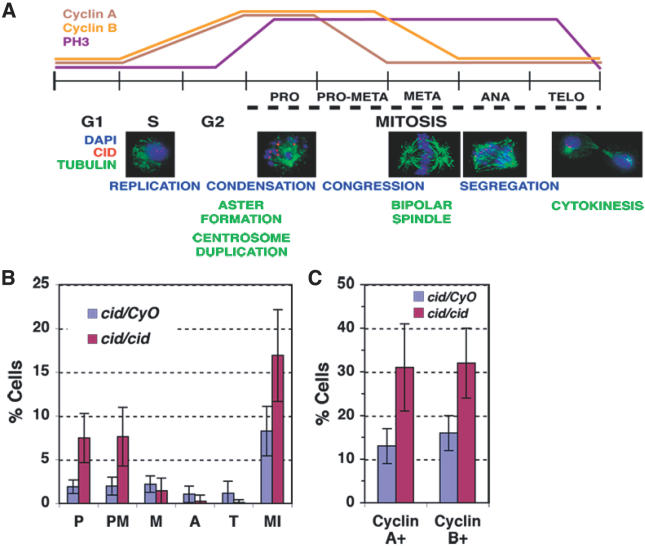

cid Null Mutants Exhibit a G2/Prophase Delay.Cell cycle progression was monitored in cid/CyO and cid/cid embryos by staining for PH3, cyclin A, cyclin B, and tubulin.(A) Schematic diagram of the appearance and destruction of various cell cycle regulatory factors and markers. ANA, anaphase; META, metaphase; PRO, prophase; PRO-META, prometaphase; TELO, telophase.(B) cid/cid animals displayed an elevated mitotic index, and an increased number of cells in prophase and prometaphase, compared to cid/CyO controls. A, anaphase; M, metaphase; MI, mitotic index; P, prophase; PM, prometaphase; T, telophase.(C) cid/cid animals had a 2-fold higher number of cyclin A and B positive cells than cid/cid controls. Scale bars indicate 15 μm.